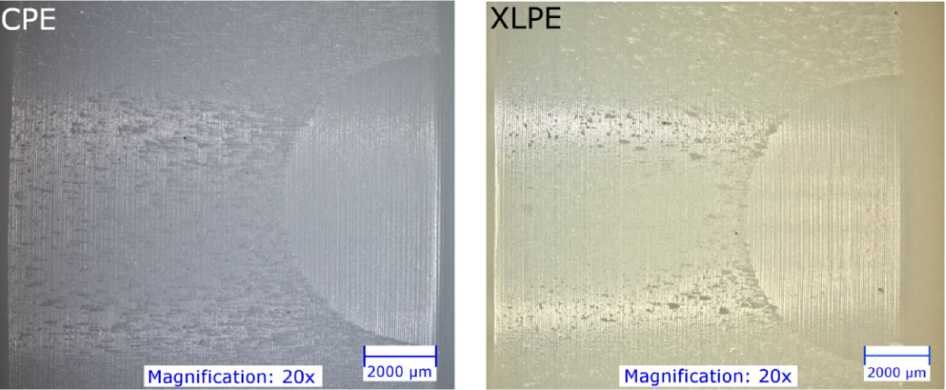
Figure 5. Photographs (Digital Microscope VHX-5000, Keyence, Japan) of the backside of the tested PE inserts.